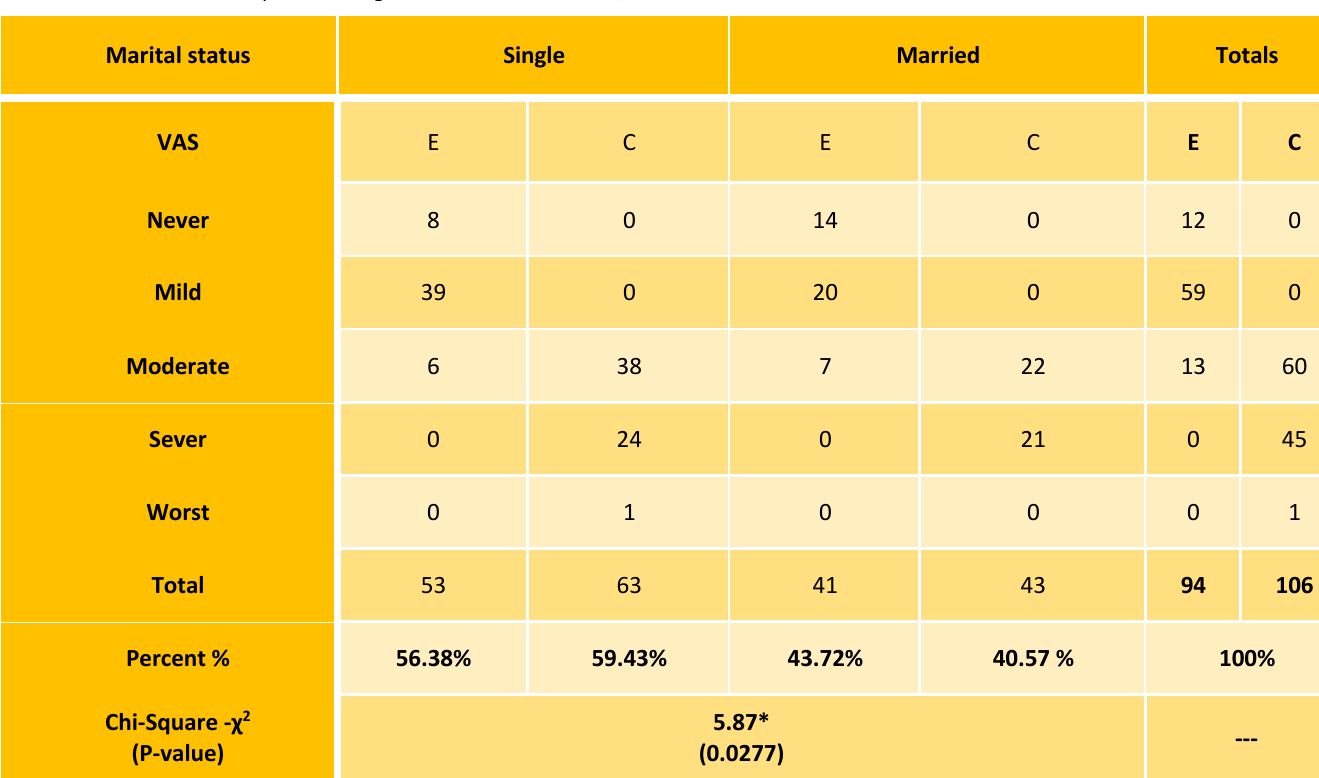
Table 5. Distribution of sample according to marital status and